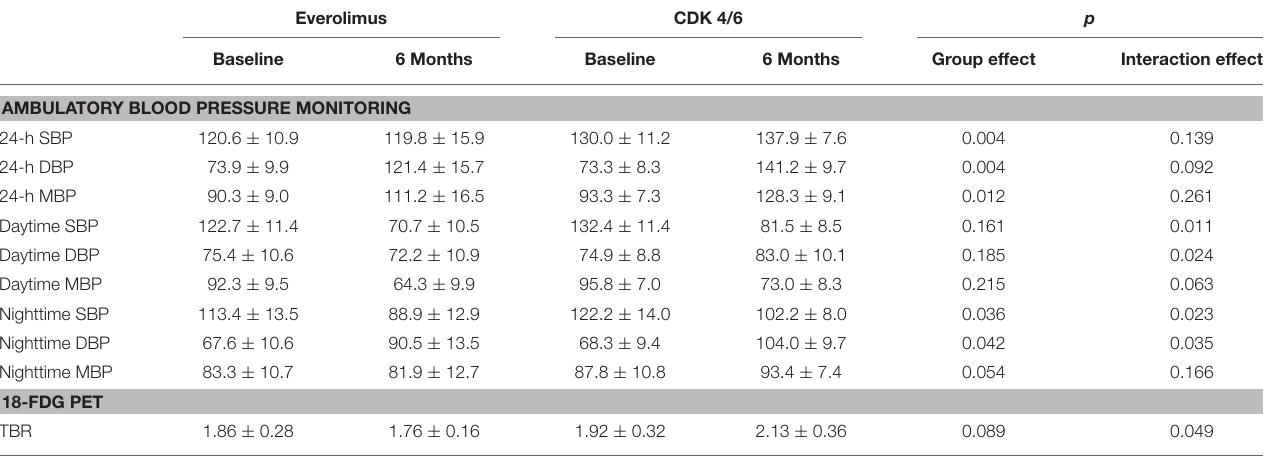
TABLE 2 | Results of repeated measurement analysis of variance for ambulatory blood pressure monitoring and 18-FDG